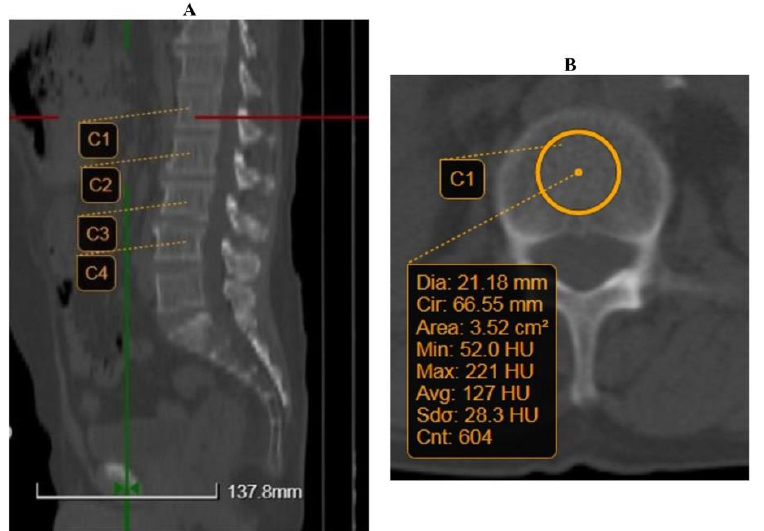
Figure 1. Example of quantitative computed tomography (QCT) measurement. ( A ) Reconstructions were obtained in the axial plane. ( B ) Region of interest (ROI) was chosen to be around 20 mm. C1–C4, L1–L4 lumbar vertebral corpus.